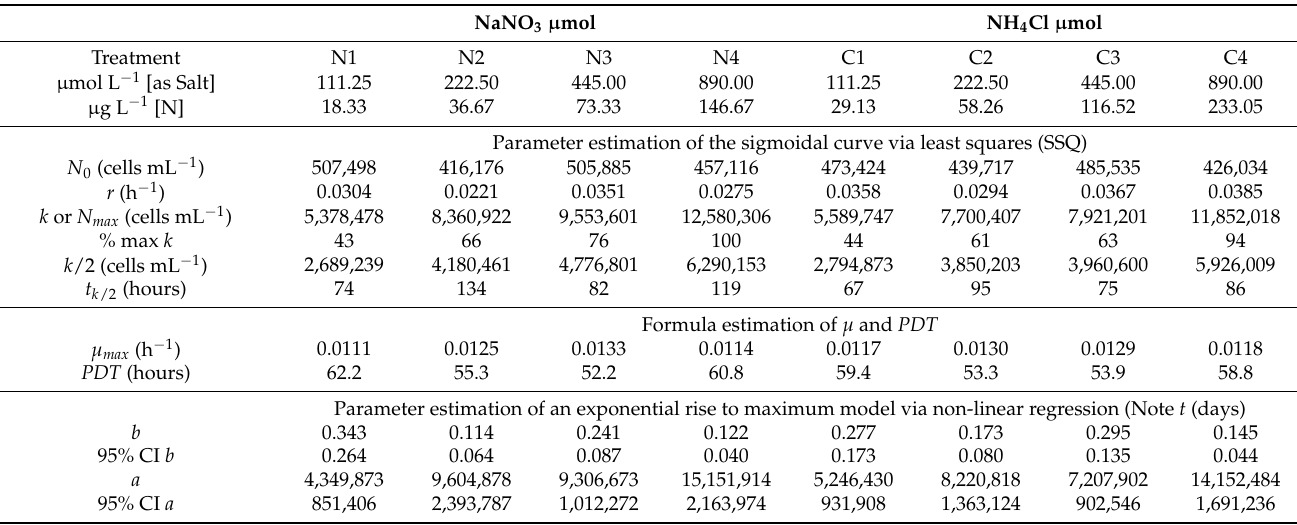
Parameter estimation of an exponential rise to maximum model via non-linear regression (Note t (days) b